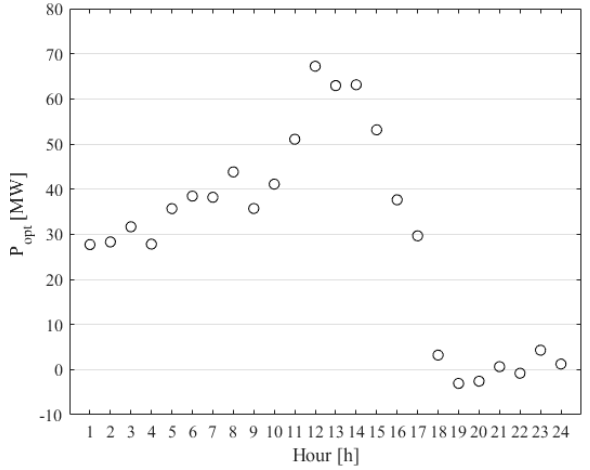
Figure 13. Optimal operating point of MVDC link candidate #2.